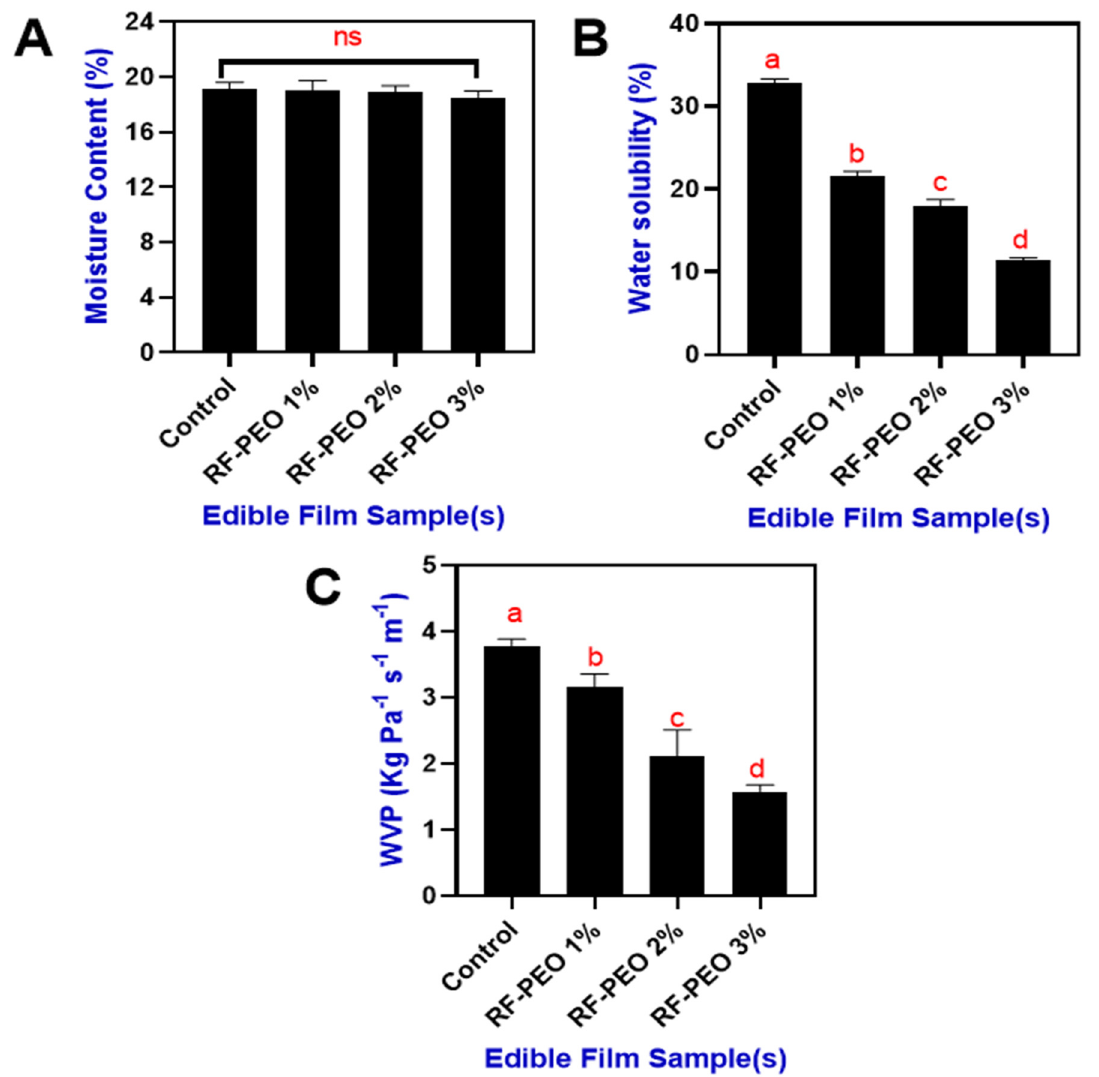
Figure 4. Moisture content ( A ), water solubility ( B ) and WVP ( C ) of edible films that made of RF-PEO at varying concentrations. The different letter of the alphabet shown on the bar diagram indicate significant differences and ns indicates non-significant di ff erences.